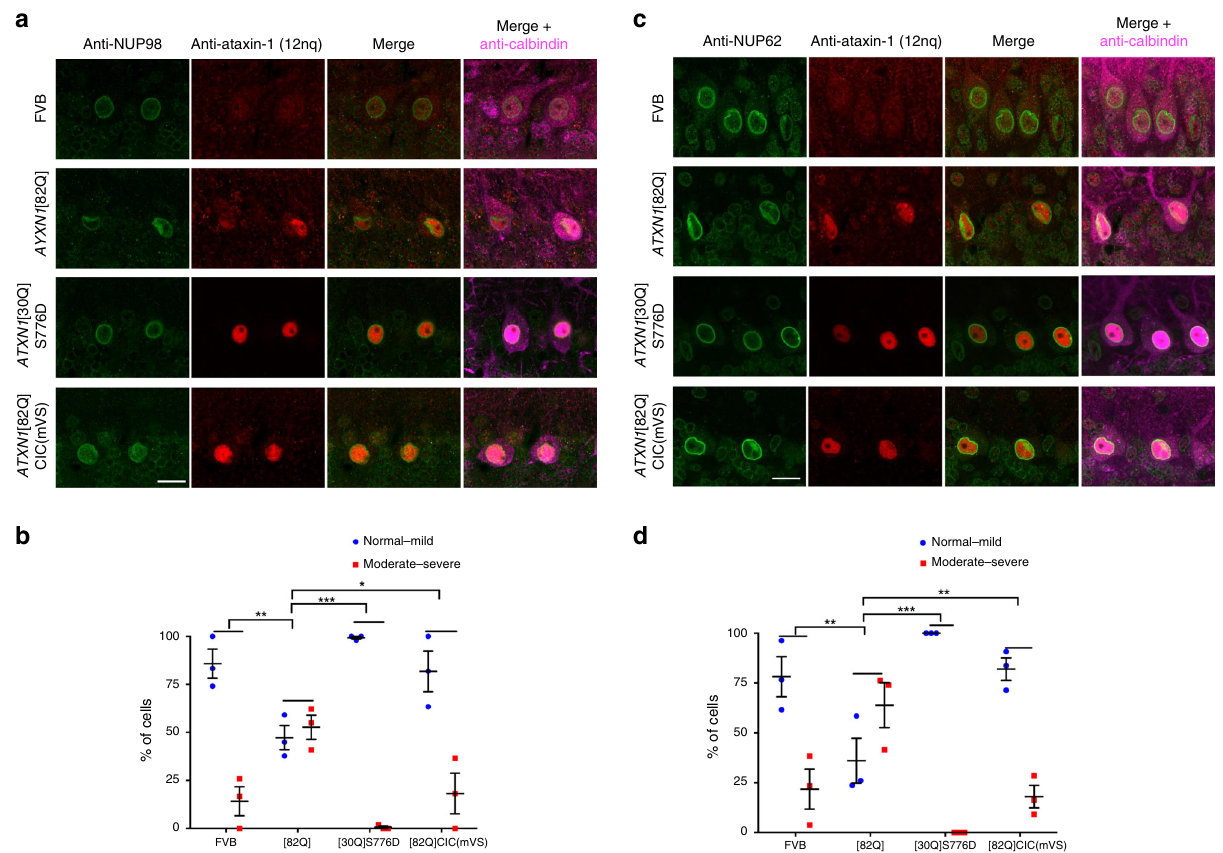
Fig. 7 Nucleoporins NUP98 and NUP62 are mislocalised in Purkinje cells in SCA1 mice. Mice (12 weeks old) of each genotype ((FVB, ATXN1 [82Q], ATXN1 [30Q]S776D and ATXN1 [82Q]CIC(mVS)) were anaesthetised and cerebellum sections were cut for staining and imaging. NUP98 (green), ataxin-1 (red) and calbindin (magenta, a marker of Purkinje cells) were detected by immuno fl uorescent staining. Merge panels a NUP98 + ataxin-1 or NUP98 + ataxin-1 + calbindin and c NUP62 + ataxin-1 or NUP62 + ataxin-1 + calbindin are shown. a , c Scale bars = 20 μ m. b NUP98 nuclear rim staining or d NUP62 snuclear rim staining was scored as normal-mild (round to mostly round with ≤ 2 small to medium-sized wrinkles) or moderate-severe (elongated with large invaginations and distorted morphology) by an observer blinded to the animal genotype; results were calculated as the percentage of Purkinje cells of each type. Results represent the mean ± SEM calculated using the following numbers of analysed cells in mice: FVB n = 343 ( b ) or 365 ( d ) cells from 3 mice, [82Q] n = 291 ( b ) or 347 ( d ) cells from 3 mice, [30Q]S776D n = 290 ( b ) or 271 ( d ) cells from 3 mice, [82Q]CIC(mVS) n = 228 ( b ) or